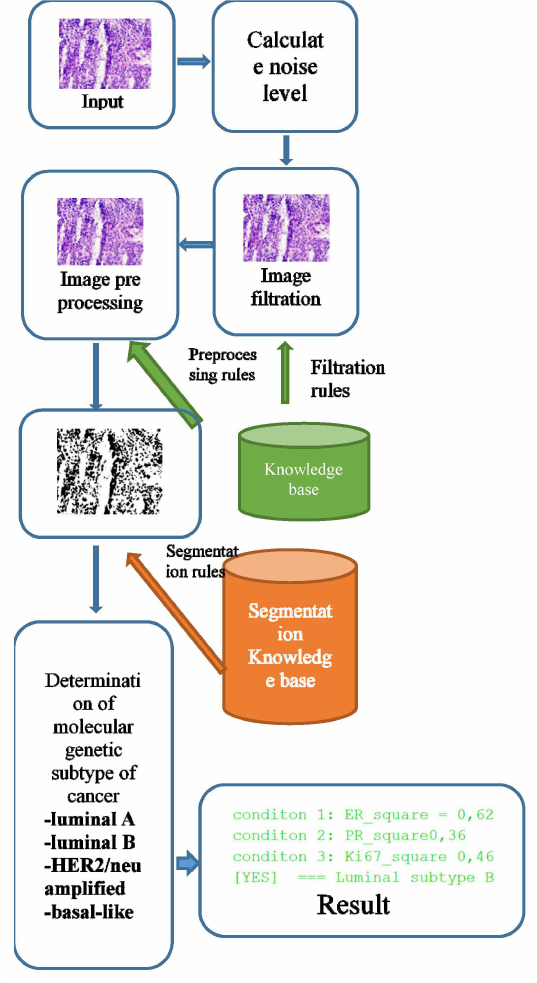
Figure 1. Software module of the generalized